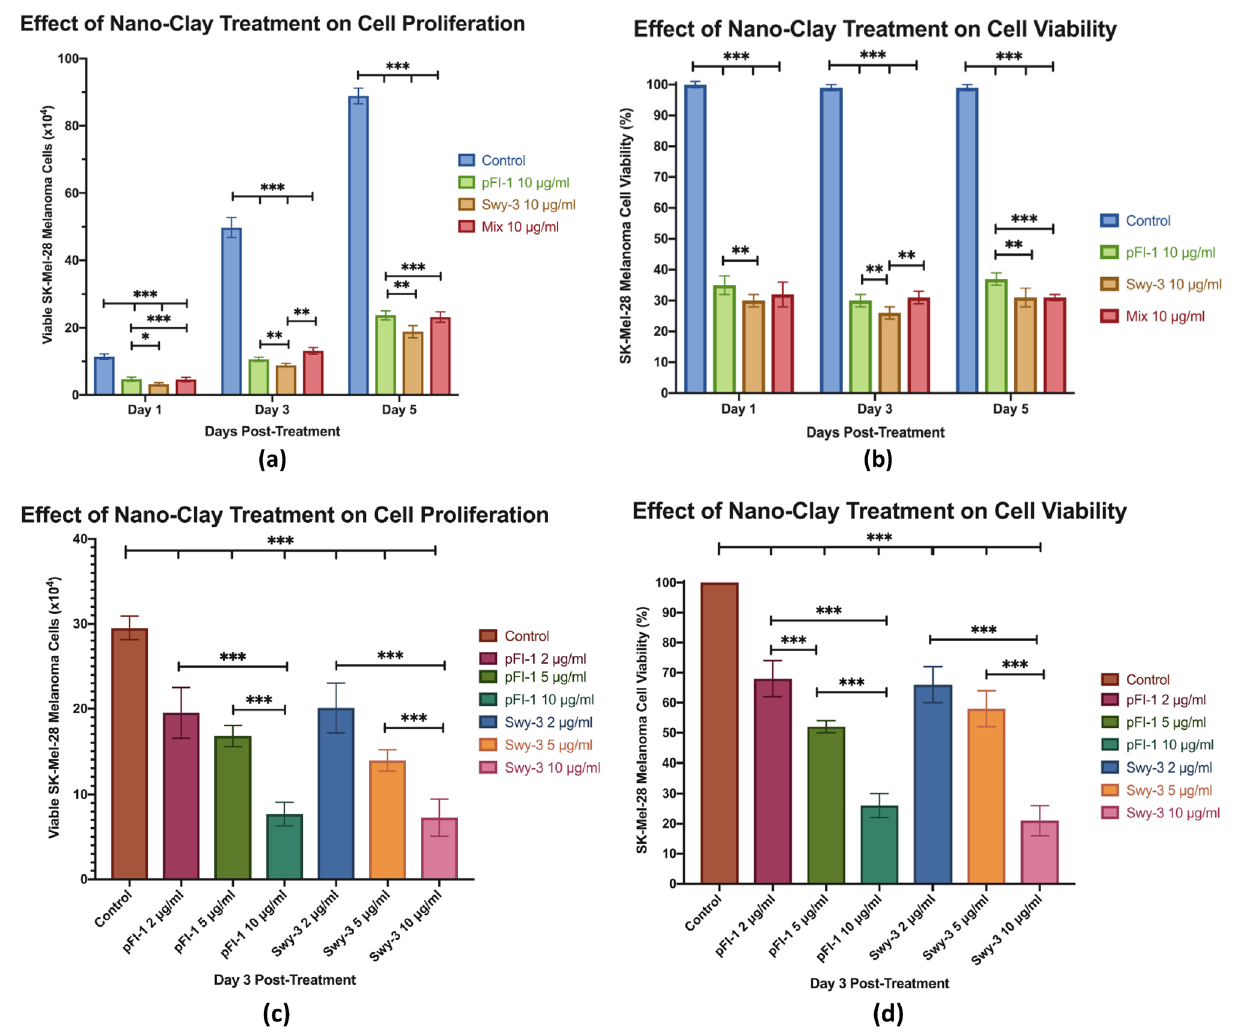
viability in a dosage-dependent manner. SK-Mel-28 melanoma cells were treated with PFl-1, SWy-3 and the mix (25:75) at concentrations of 0 (control), 2, 5 or 10 μg/ml for 5 days. The numbers of viable cells were counted at days 1, 3, and 5 post-treatment, and viable cell numbers for the treatments were presented as columns. Standard deviation is represented in the figure by a bar attached to each column. Significant differences at p < 0.05, p < 0.01 and p < 0.001 are denoted by *, ** and ***,